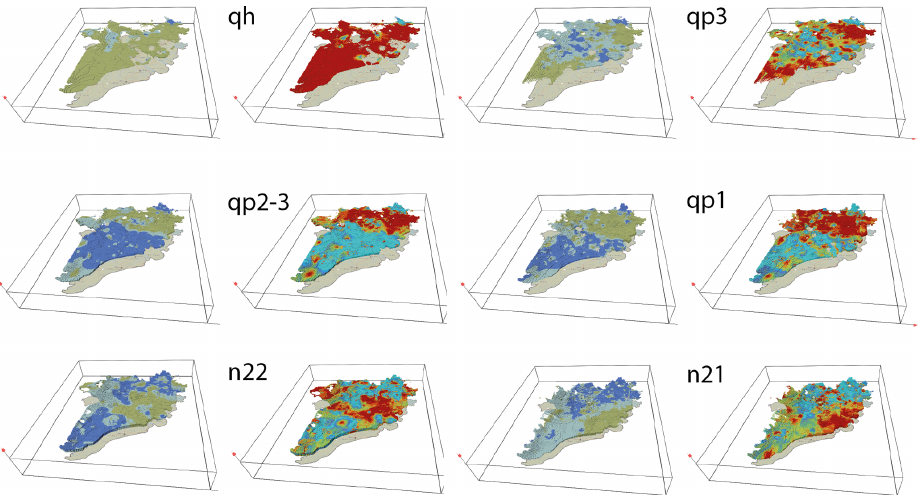
Figure 12. Three-dimensional perspective view of the spatial distribution of fresh, brackish and saline (left panels) and the probability that TDS < 1gL − 1 (right panels) for the aquifers in the area. For legend see Fig. 11.